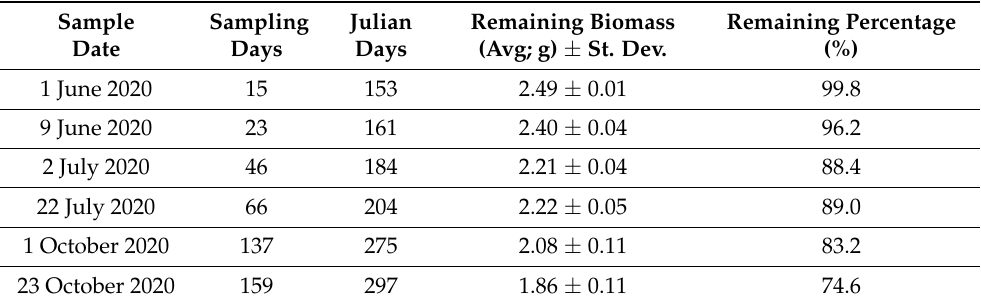
Table 1. Remaining Biomass (Avg, g), standard deviation ( St.Dev ., g), and remaining percentage with respect to t 0 (t 0 = 14 May 2020), during the sampling time (from 153 to 297 Julian days).